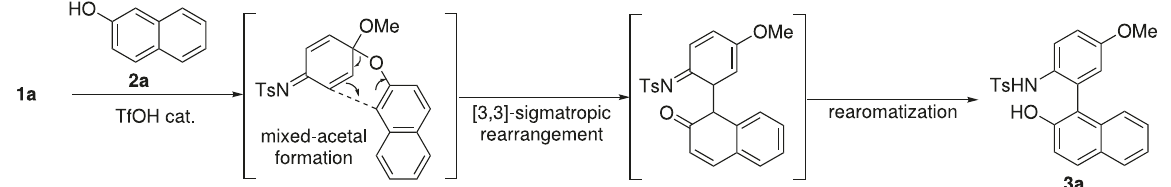
Fig. 5 Plausible mechanism. TfOH promotes mixed-acetal formation from 1a and 2a . Then, [3,3]-sigmatropic rearrangement and rearomatization provide compound